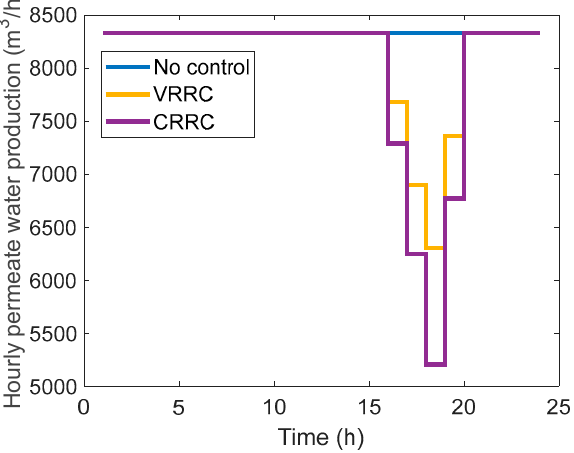
Figure 10. Fresh water hourly production rate of the three operational schemes.